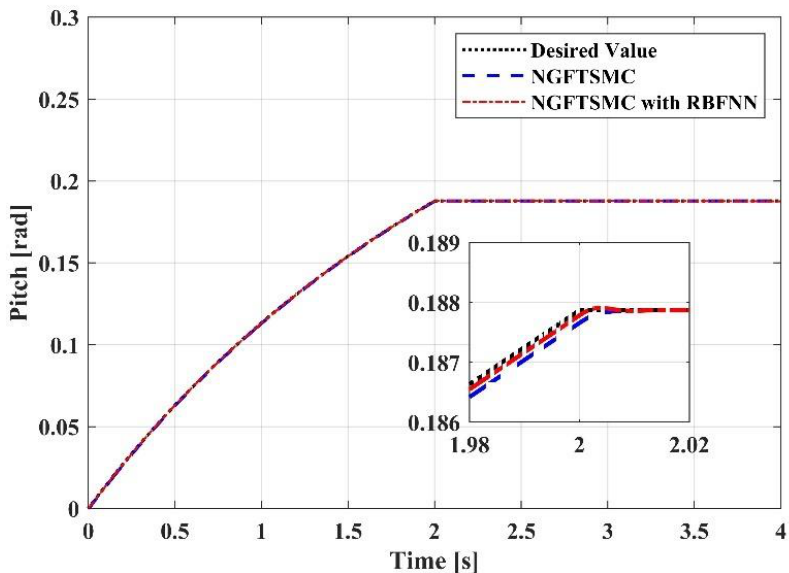
Figure 10. The trajectory tracking results in pitch angel.